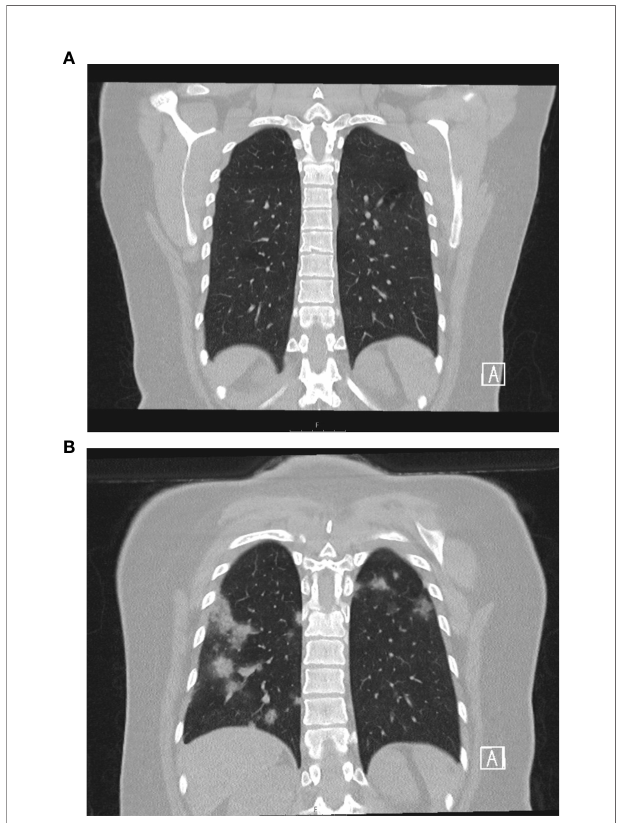
FIGURE 1 | Chest CT scans on day 3 after admission (A) without signs of COVID-19 and day 34 (B) showing COVID-19